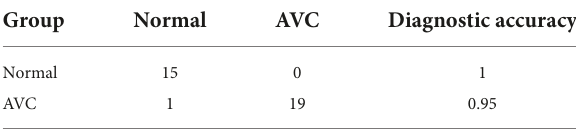
TABLE 6 Diagnostic accuracy for all samples of the combined dataset of GSE12644 and GSE51472. Group Normal AVC